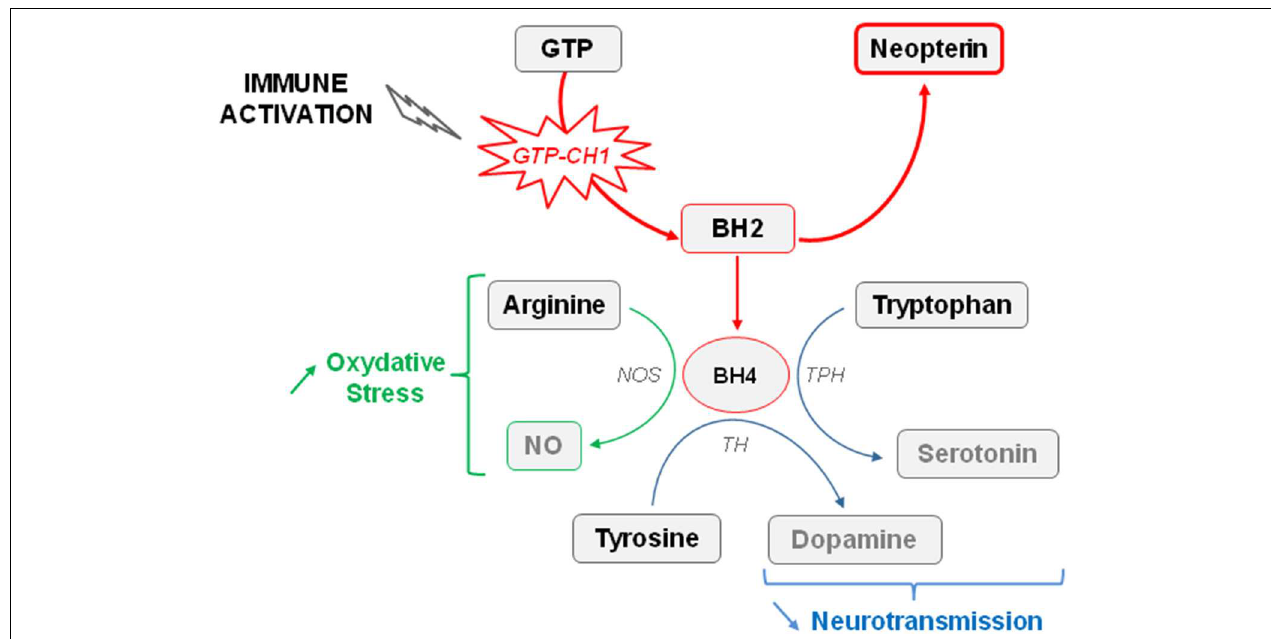
FIGURE 2 | Effect of immune activation on the availability of tetrahydrobiopterin (BH4). The guanosine-triphosphate-cyclo hydrolase-1 (GTP-CH1) is the rate limiting enzyme of guanosine- triphosphate (GTP) conversion in dihydrobiopterin (BH2). Increased GTP-CH1 activity occurring in conditions of immune activation ultimately leads to the production of neopterin at the expense of tetrahydrobiopterin (BH4) formation. BH4 plays a fundamental role in